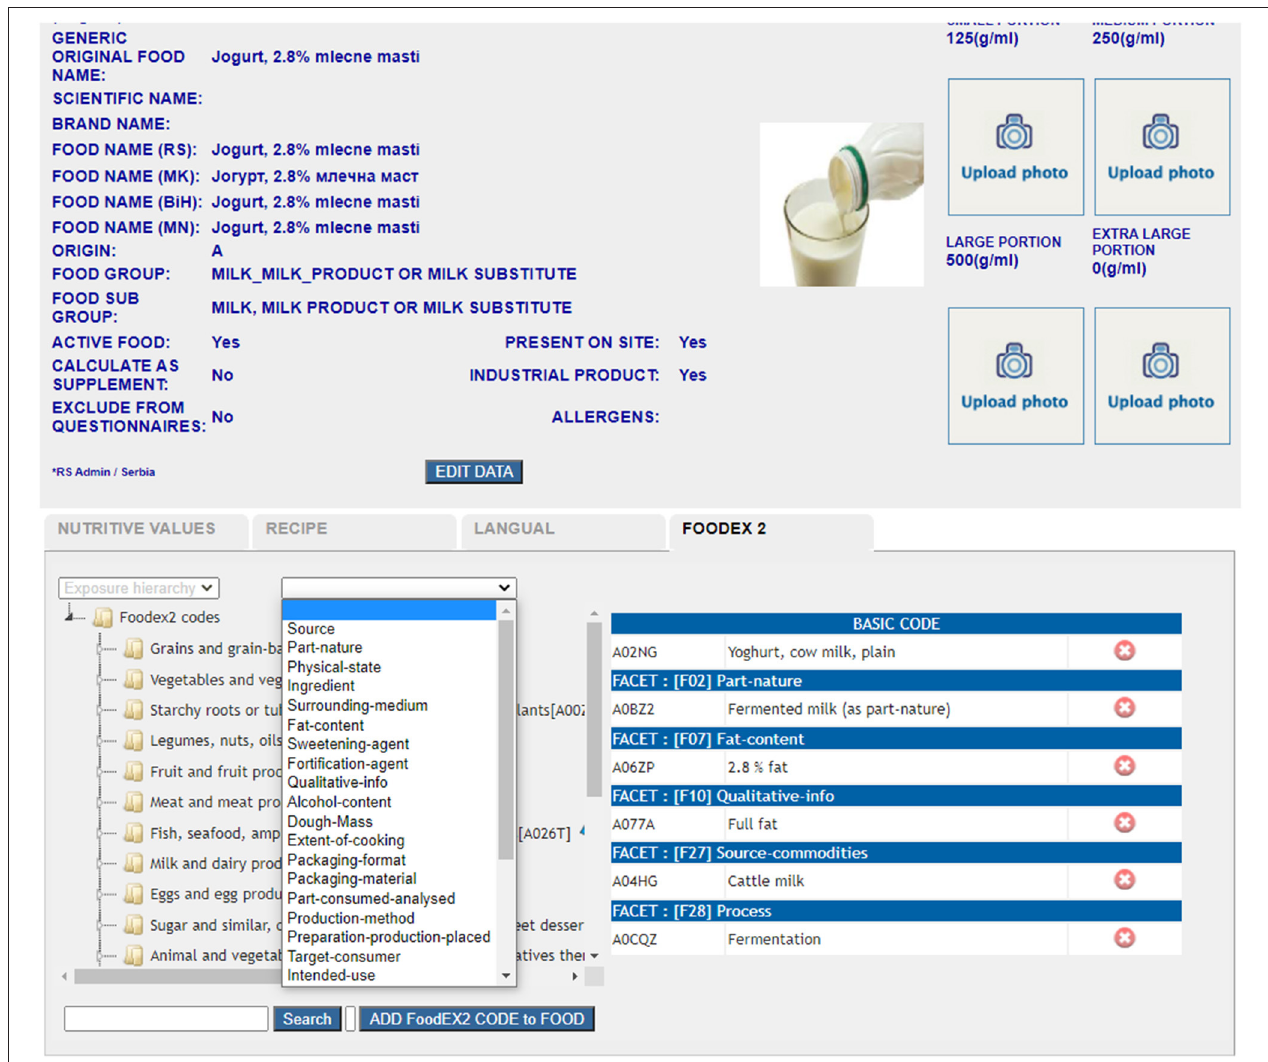
FIGURE 1 | FoodEx2 coding on the level of the food item incl. all required facet